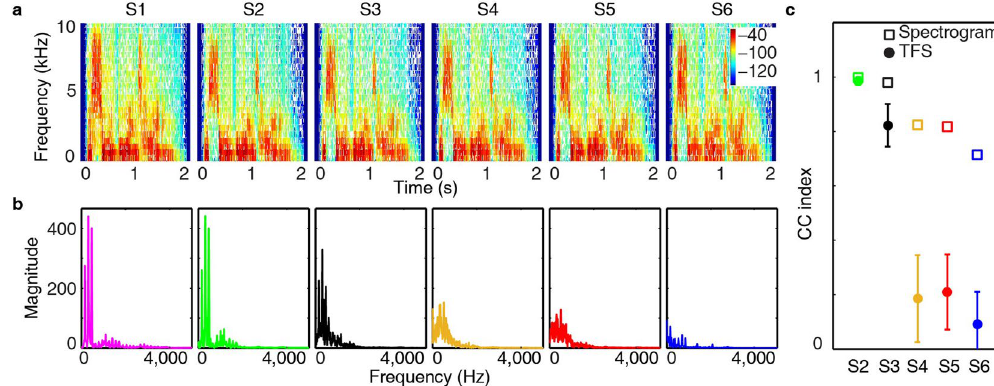
Figure 1. The narrow band spectrogram of S1 to S6 shows the energy of the sentence as a function of time and frequency ( a ). The CC index was calculated between the spectrogram of S1 and S2–S6 ( c ). The second “i” from the sentence “the silly boy’s hiding” was selected as an example. The spectra of “i” from 0 to 5000 Hz were plotted for each type of sentence ( b ). Similar color coding was used for all following figures. The representative peaks in S1, S2, and S3 share the same frequencies, although the magnitudes were slightly different. For each voiced syllable, the CC index was calculated between the spectra of S1 and S2–S6. The CC index was averaged across all voiced syllables (n = 9) in the sentence. The averaged CC index and the standard deviation were plotted for each sentence as solid circles and error bars ( c ). The CC index was also calculated between the spectrogram of S1 and S2–S6, as shown in open squares ( c ).